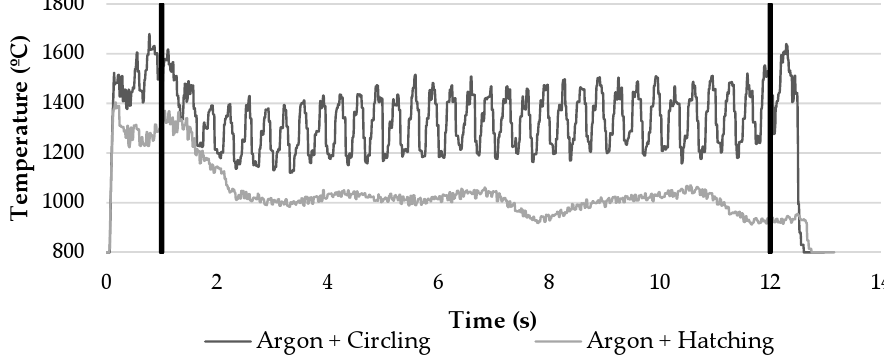
Figure 13. Nineteenth layer temperature representation for Argon Q1 shielding gas at 30 L/min gas flow.